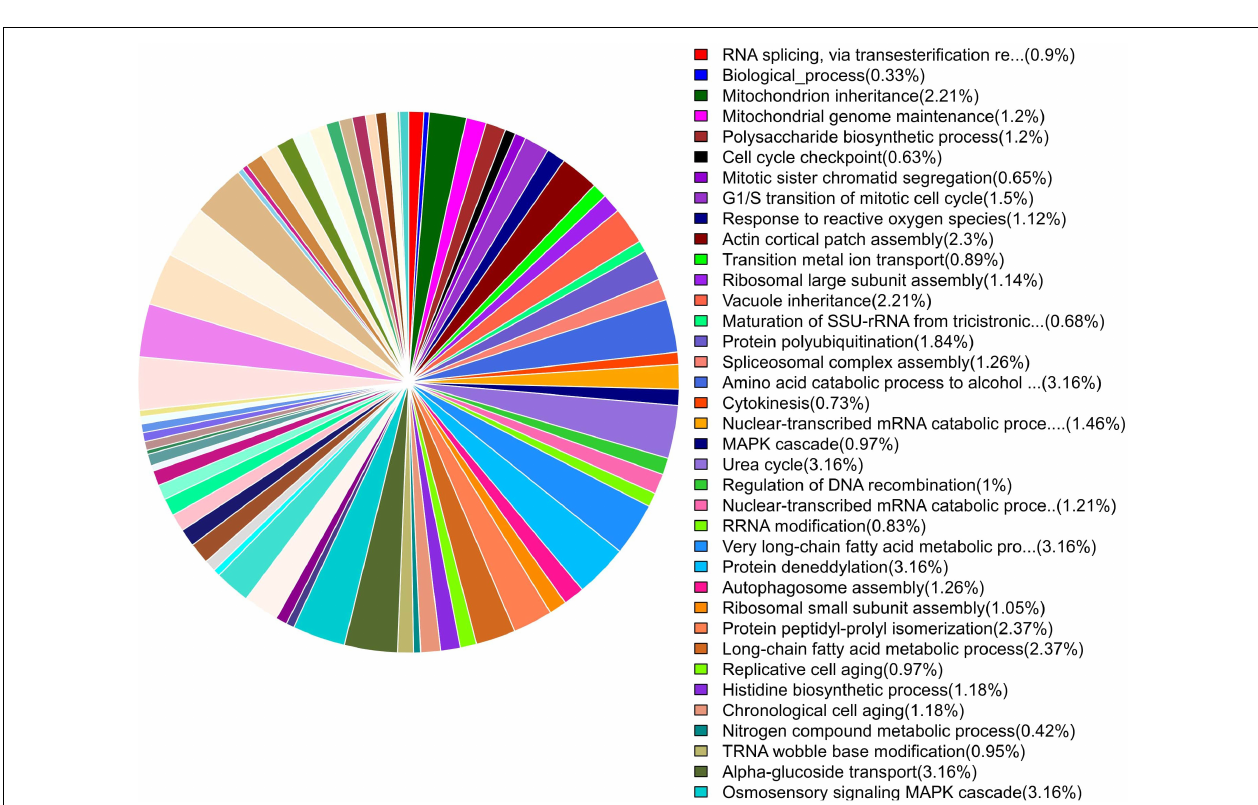
FIGURE 4 | Pie chart of enriched GO terms of B. maydis for biological functions differentially expressed in inoculated resistant and susceptible plants.